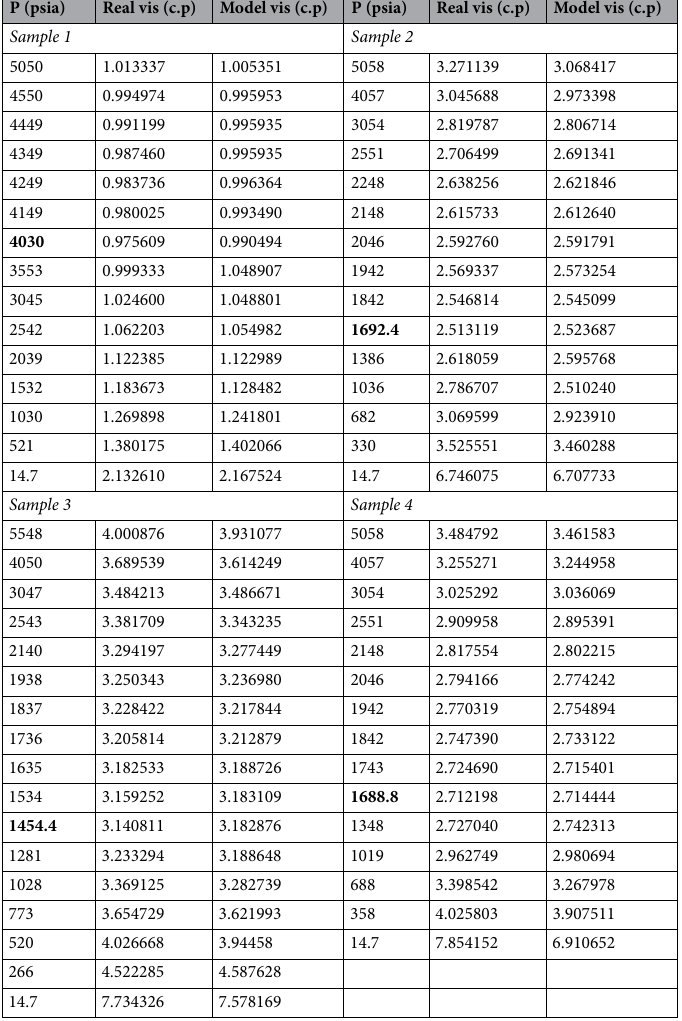
Table 6. Experimental viscosity values and the XGBoost model estimations for four Iranian oil samples at different pressures. Bubble point pressure values are shown in